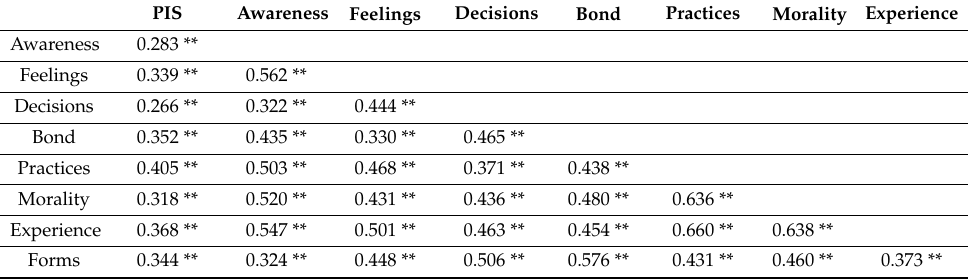
Table 5. Correlations between PIS and SLRT—study